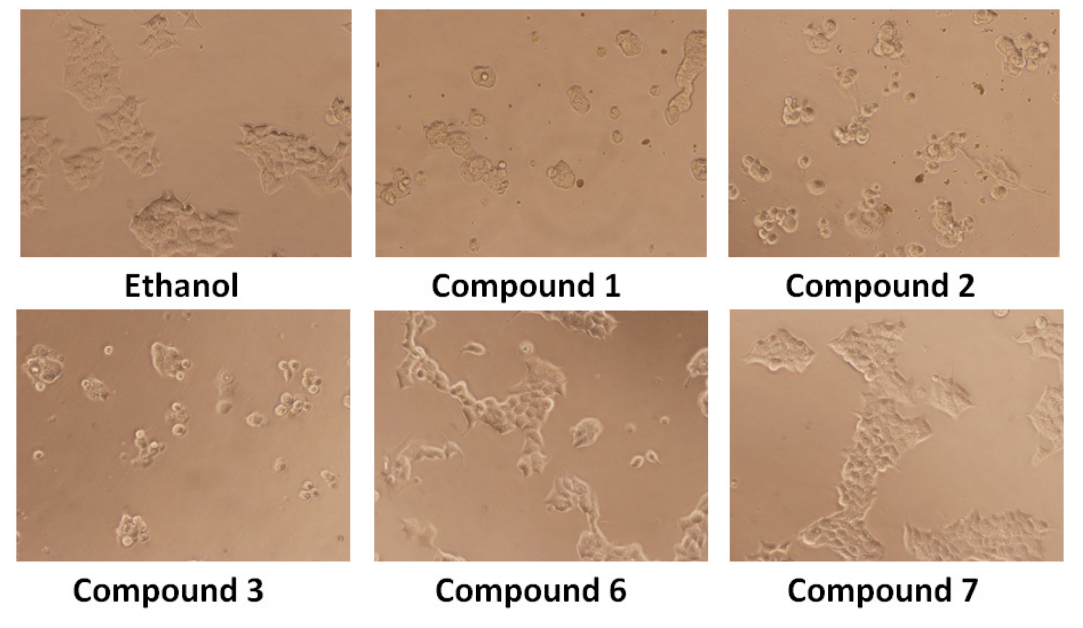
Figure 2. Effect of compounds on the morphology of the cells. After 24 h treatment morphological change of DU-145 cells observed under an inverted phase contrast microscope